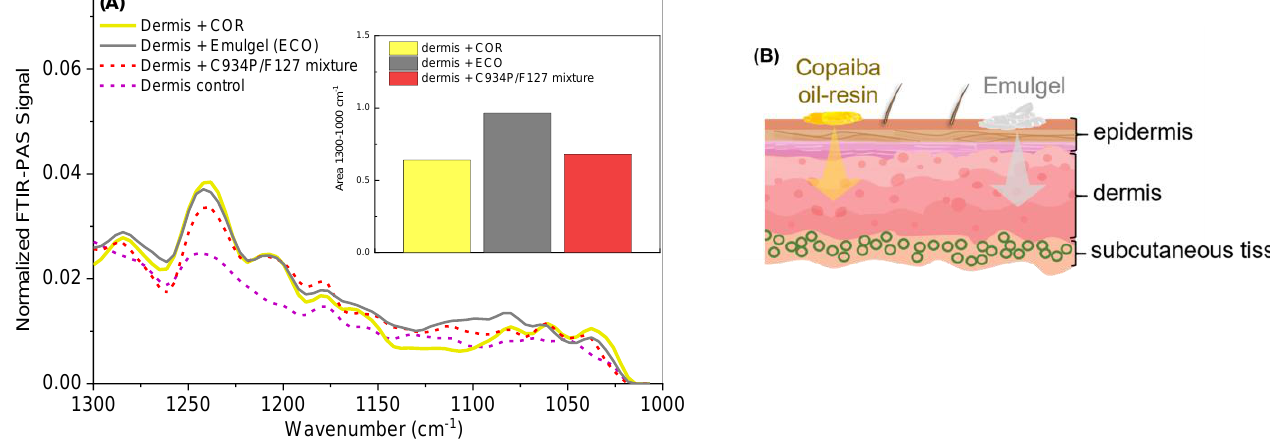
Figure 1. Normalized FTIR-PAS signal of the COR, ECO, and C934P/F127 mixture (without COR), acquired at 25 °C.